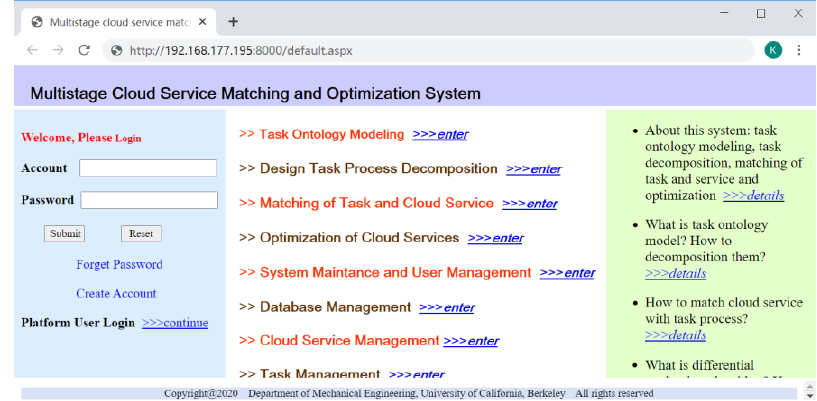
Figure 13. Interface of cloud service matching and optimization system.